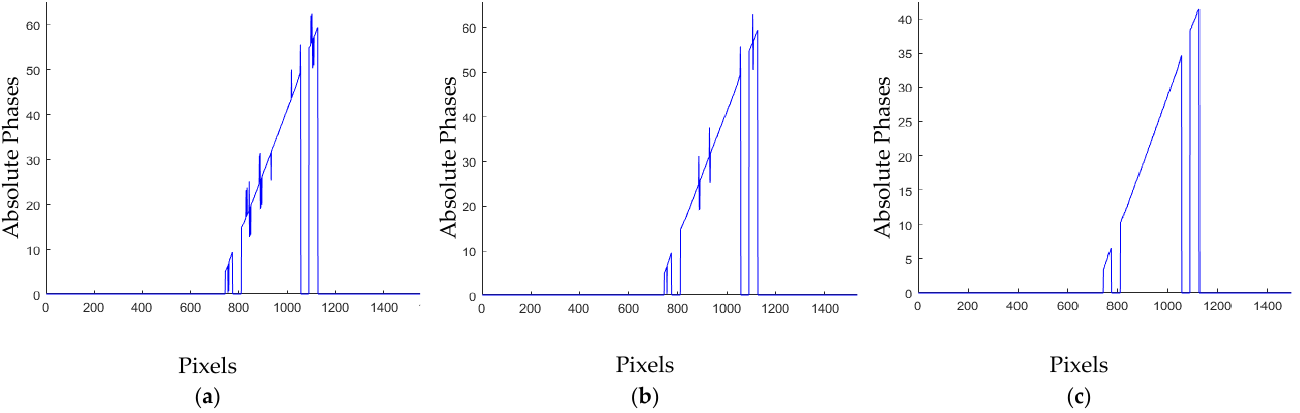
Figure 6. Absolute phase of the oil gasket acquired by di ff erent methods. Traditional method ( a ). Method of [15] ( b ). Method of this paper ( c ).